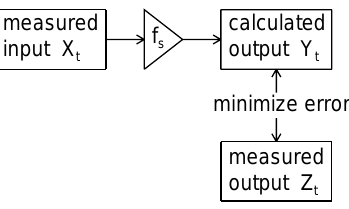
Fig. 1. Schematics of the concepts of the Linear Prediction Theory. The measured input X t is filtered (filter function f s ) yielding a cal- culated output Y t which is then compared to the actually measured output Z t . The error power between Y t and Z t shall be